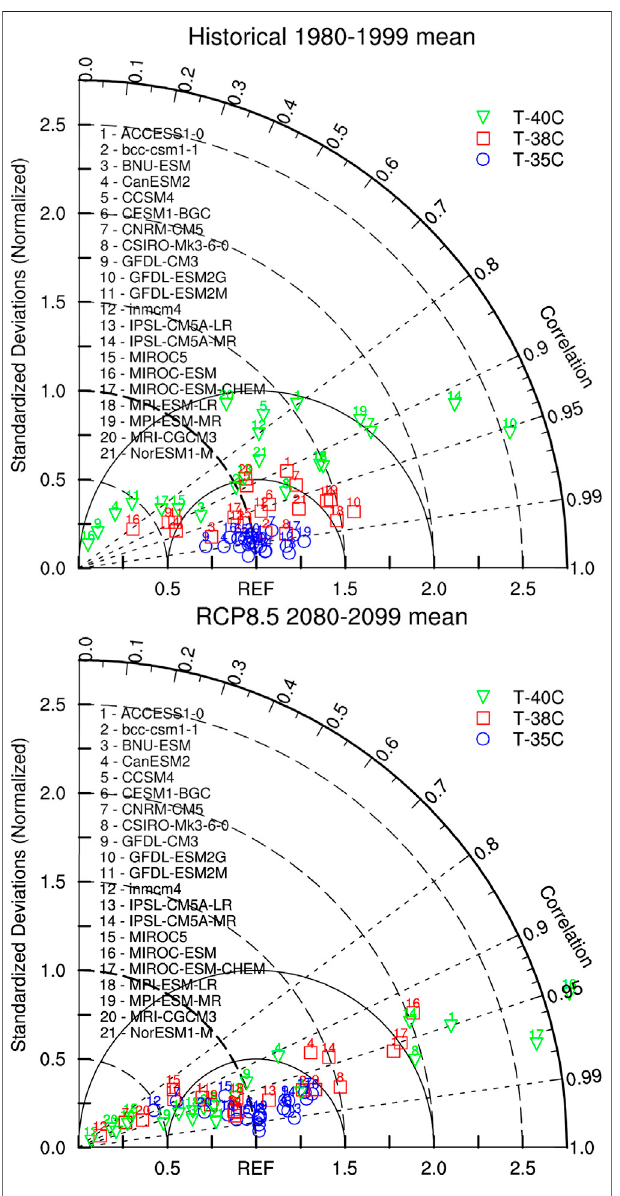
FIGURE 2 | Taylor diagram showing model biases apart from MME mean (marked as REF) in simulating the EHTDs at different levels averaged over historical period of 1980 – 1999, and RCP8.5 period of 2080 – 2099.